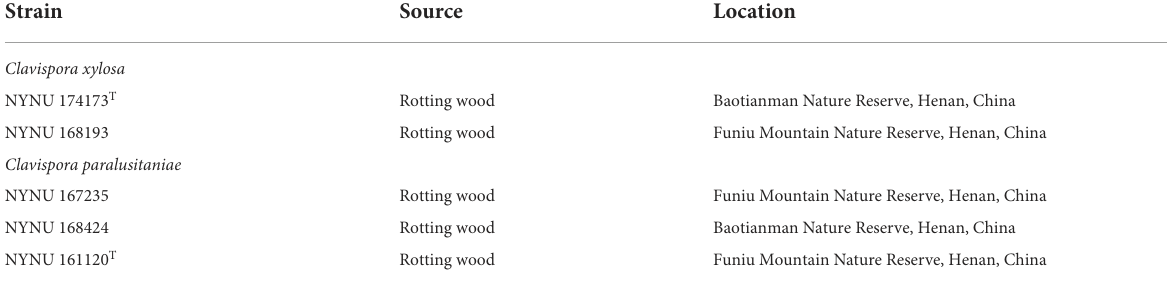
TABLE 1 Novel yeast strains isolated from rotting wood.